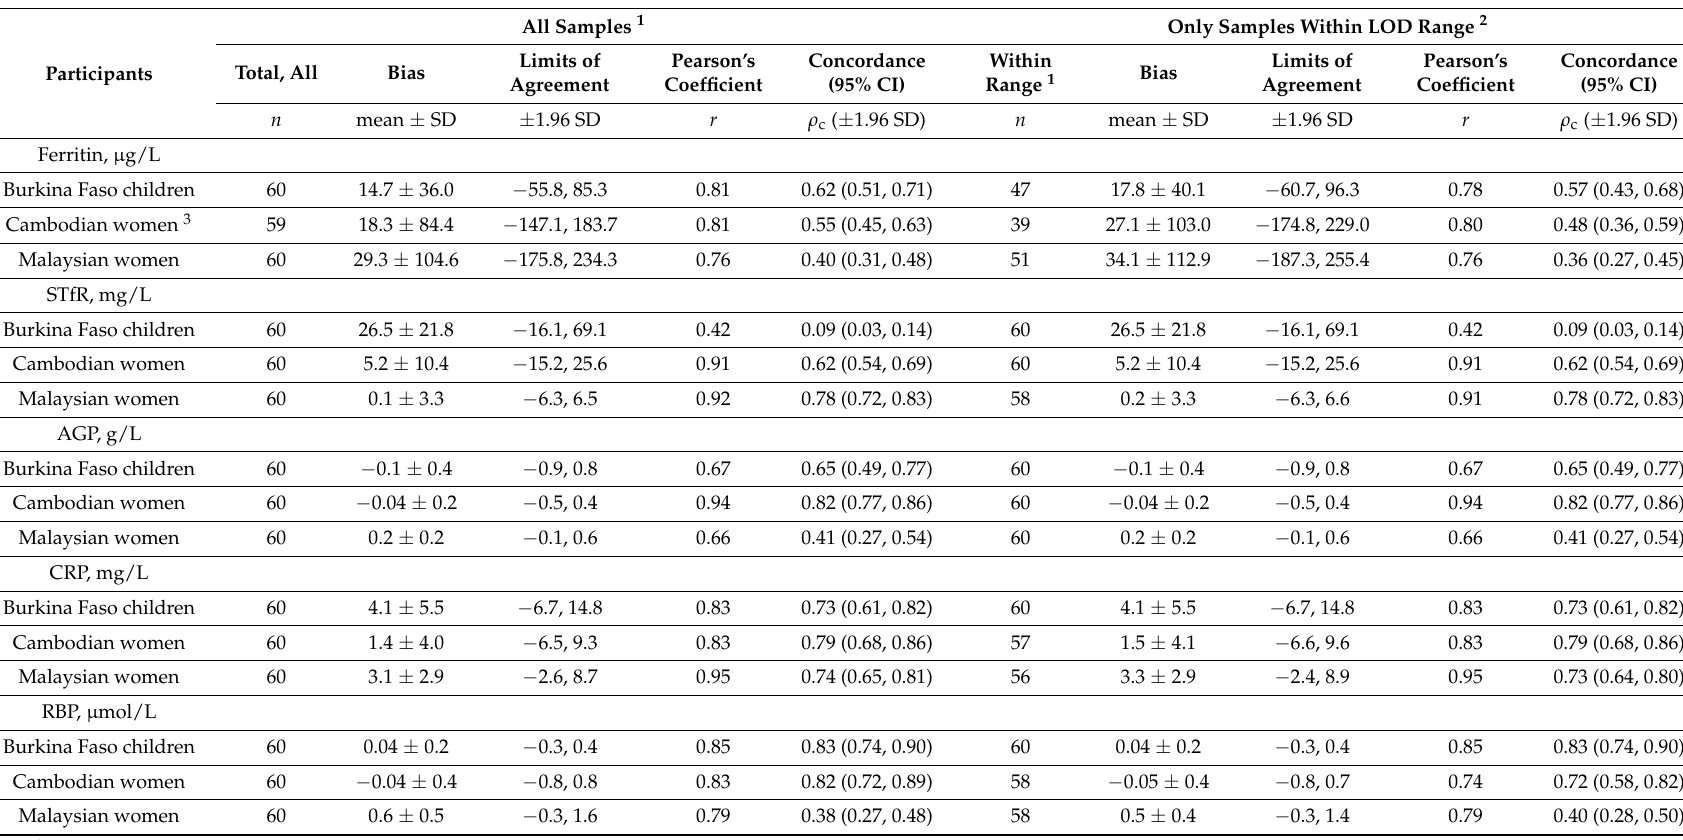
Table 5. Bias, limits of agreement, and correlation coefficients of ferritin, soluble transferrin receptor (sTfR), α 1 -acid glycoprotein (AGP), C-reactive protein (CRP), and retinol-binding protein (RBP) concentrations comparing the s-ELISA and the Quansys ELISA